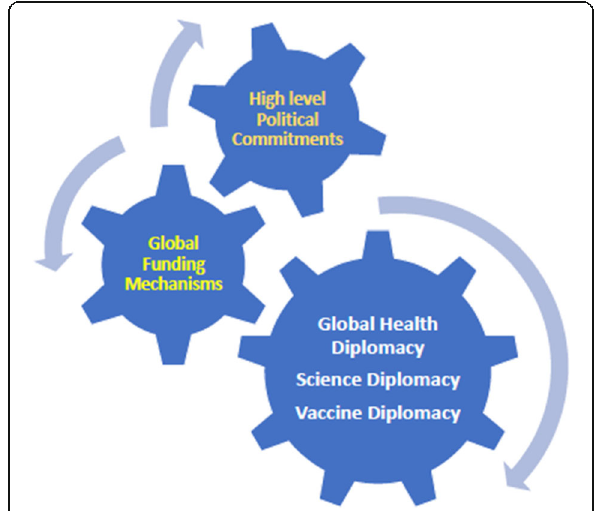
Fig. 1 Dynamics between global health diplomacy, political and financial commitments for global